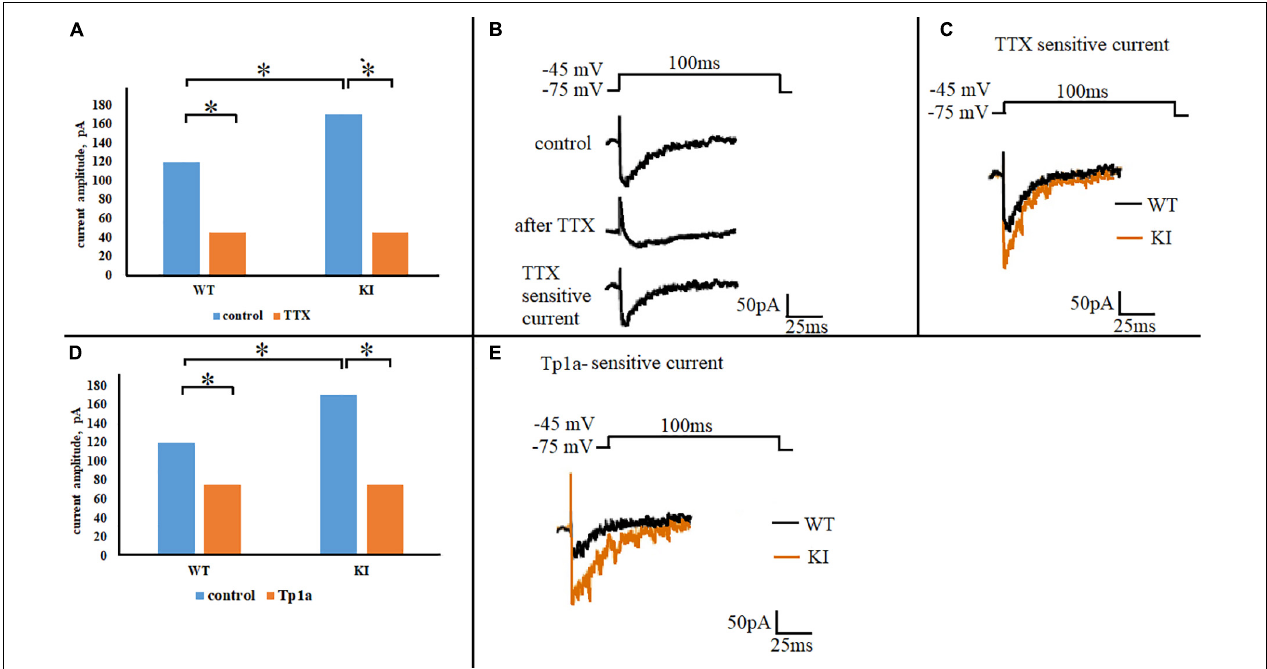
FIGURE 4 | Na V 1.7 current in WT and R192Q KI TG neurons. (A) Mean amplitudes of the currents evoked by a square pulse 100 ms depolarizing step from –75 to –45 mV, in WT and R192Q KI TG neurons under control conditions and after application of 1 µ M TTX. Note larger control current in KI (* p = 0.039, two-sample Student’s t -test). Number of cells in each group: n = 29 (WT, control), n = 20 (WT, TTX), n = 43 (KI, control), i = 24 (KI, TTX). (B) Representative traces of inward currents recorded from one WT neuron in response to the same stimulation in control and after 1 µ M TTX; the trace of TTX-sensitive current was obtained by subtraction of the TTX-resistant current from the control. (C) Superimposed representative traces of WT and KI TTX-sensitive currents obtained by subtraction; note larger KI current. (D) Histograms represent the calculated mean amplitudes of the currents evoked by the same stimulus (100-ms step from –75 to –45 mV) in control and after Tp1a (7 nM, 30 min). *Indicates statistically significant change (two-sample Student’s t -test, p -values are given in the text body). Number of cells in each group: n = 29 (WT, control), n = 28 (WT, Tp1a), n = 43 (KI, control), n = 38 (KI, Tp1a). (E) Superimposed representative traces of WT and KI Tp1a-sensitive (Na V 1.7) currents obtained by subtraction of the TTX-resistant current from the control; note larger Na V 1.7 current in